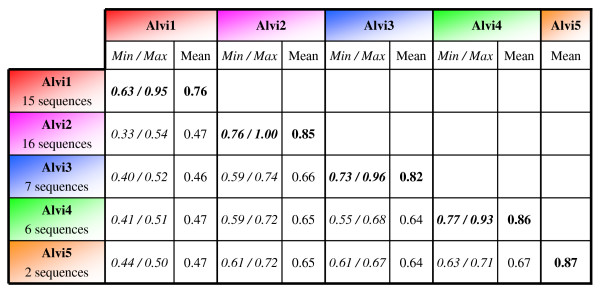
Nucleotide sequence identity matrix of the Alvi1 to Alvi5 families. The matrix is built using the pairwise deletion of gaps option included in the MEGA4.1 software. Results of intra-family computation are given in black bold. For each intra or inter-families observation, the mean of DNA identity is indicated as well as the lowest and highest (Min/Max) values represented in italics. The number of sequences included in each Alvi family is also noted.